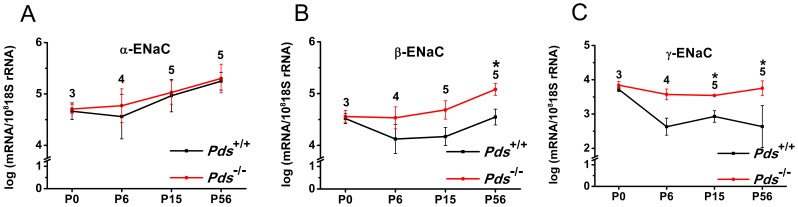
Differences of transcript expression of αENaC (A), βENaC (B), and γENaC (C) in the vestibule between Pds+/+ and Pds−/− mice.The transcripts of βENaC and γENaC were significantly upregulated at P56 and from P6 to P56, respectively, in Pds−/− compared with Pds+/+ mice. *p<0.05, numbers above the bars represent the number of experiments.